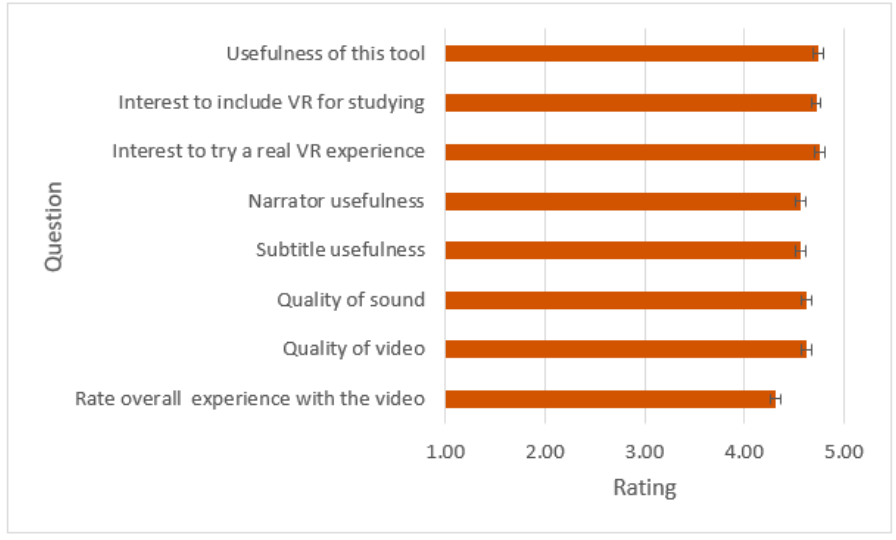
Figure 22. Average rating for various elements from the video shown. Error bars display 95% con- fi dence interval.